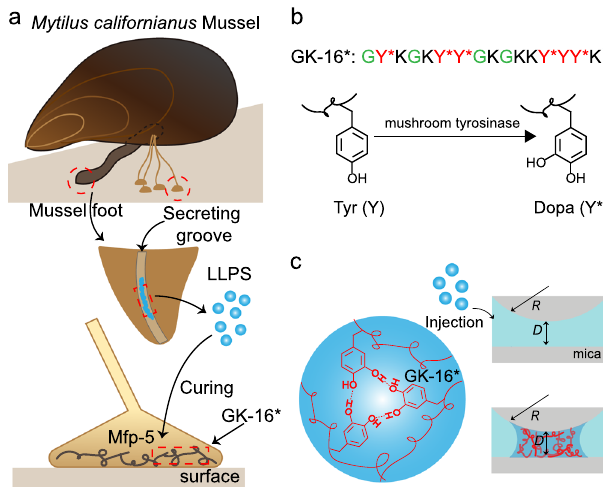
Fig. 1 | GK-16* peptides derived from Mfp-5, a primary adhesive protein in the mussel plaque. a Mytilus Californianus mussels secret and transport phase sepa- rated Mfpsthrough musselfootgroove. b Thesequence of GK-16*peptideand the enzymatic modi fi cation process of converting Tyr to Dopa. c GK-16* can form coacervate in seawater